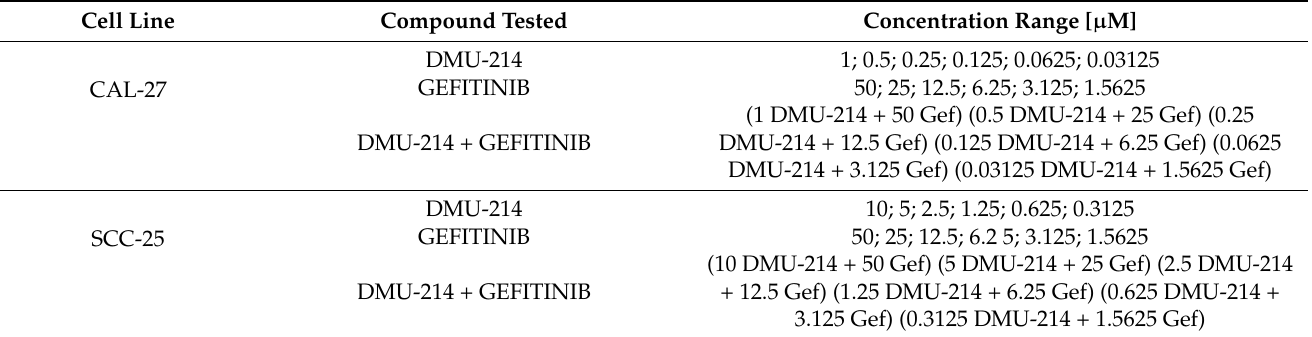
Table 2. Concentrations of DMU-214, Gef, and the mixture of DMU-214 and Gef used in MTT assay. Cell